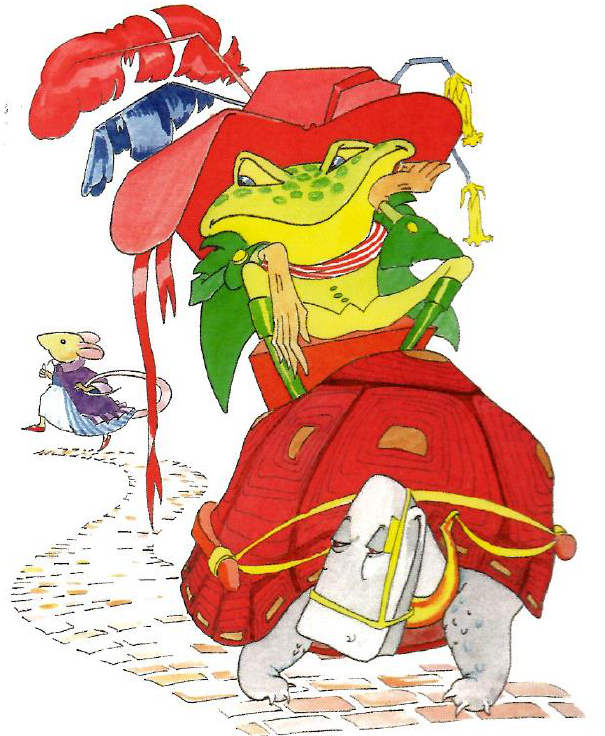
Figure 6. McMaster’s illustration for The Beautifull Cassandra (Austen 2021), p. 19.